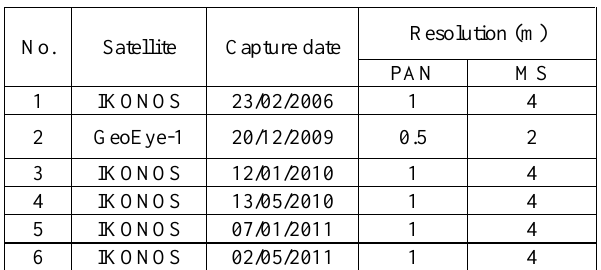
Table 1. Data Description